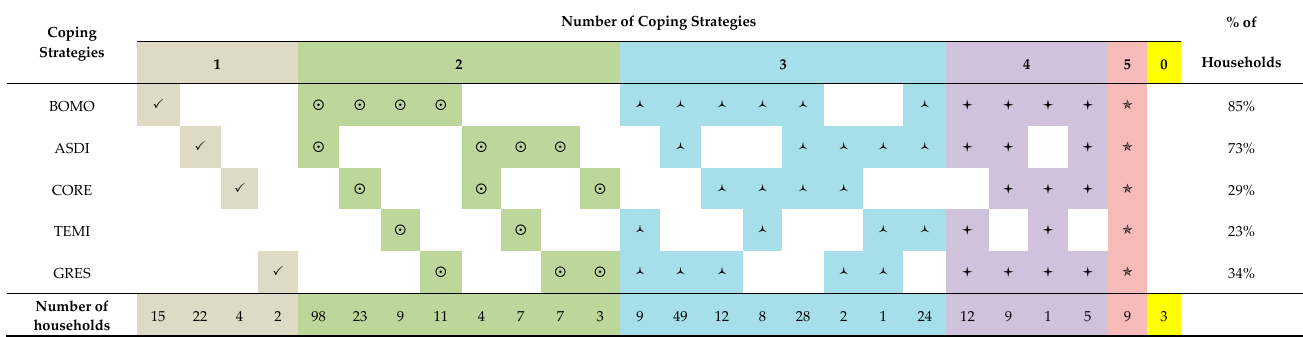
Table 3. Combination of five major ex-post coping strategies (Source: Field Survey, 2019 [N = 377]). Number of Coping Strategies